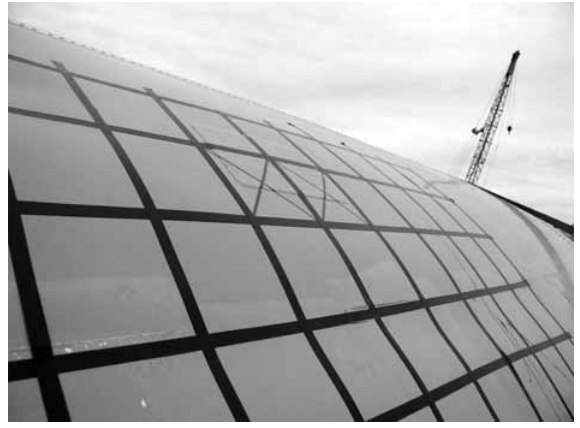
Fig. 23. Outside view of fuselage section after thick shield